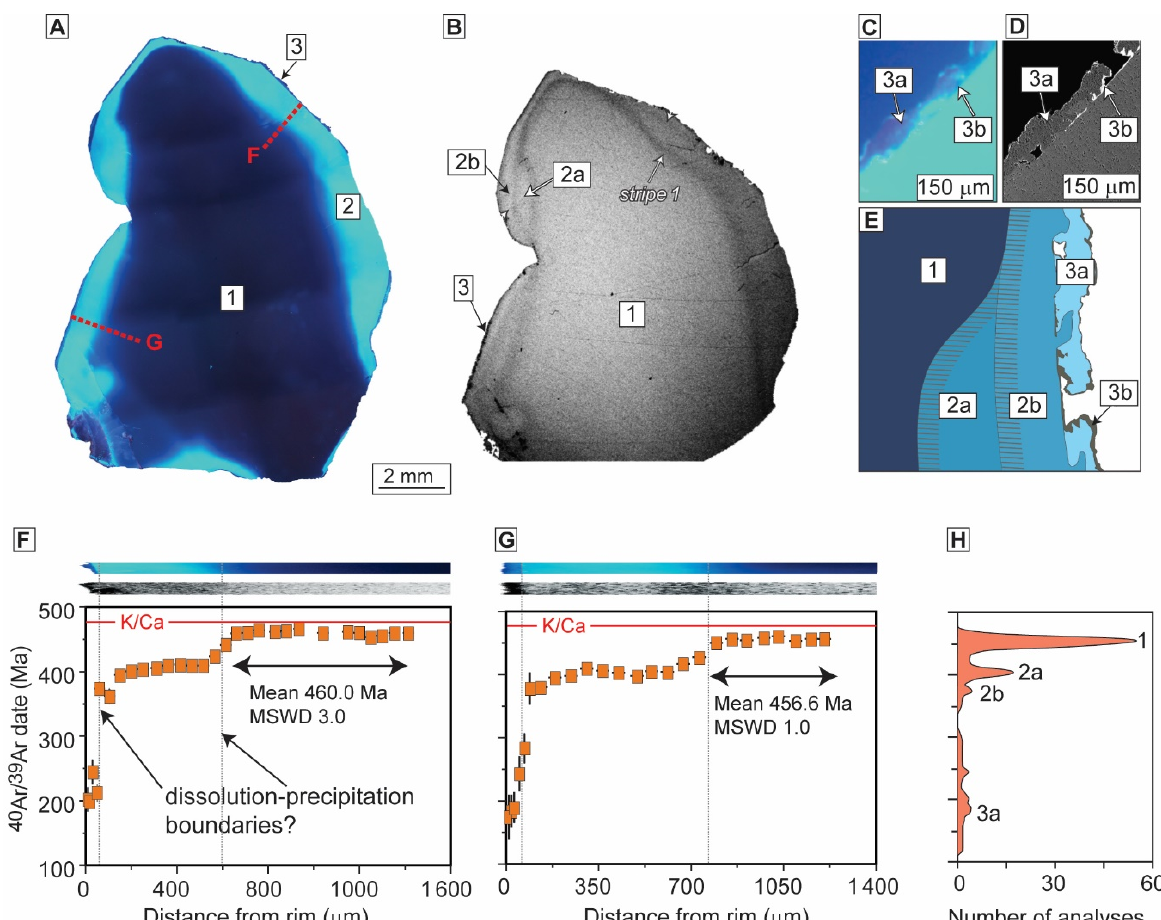
Figure 4. Gem quality orthoclase extracted from pegmatites at the site “Itrongay”, southern Madagascar, collected by the authors during field work in 2016. ( A ) Composite optical cathodoluminescence image showing three distinct zones (labeled 1, 2 and 3). ( B ) Back-scatter electron image which shows that zone 2 can be divided into two sub-zones (2a and 2b), which are separated by a dark stripe. ( C,D ) cathodoluminescence and back-scatter electron images of the outer ~300 μ m of the crystal, which show that zone 3 can be divided into 2 sub-zones (3a, 3b). ( E ) schematic sketch (not to scale) showing the relationships between all zones and their sub-zones. ( F,G ) In situ core-rim 40 Ar/ 39 Ar dates from our own in situ study [16], showing strip maps of back-scatter electron and cathodoluminescence images. Distinguishable variations in 40 Ar/ 39 Ar dates correspond with crystallographic zones, revealing periods of dissolution and diachroneity in crystallisation (~477–176 Ma). ( H ) Probability density function of all in situ 40 Ar/ 39 Ar dates collected from 8 traverses into the same crystal shown in ( A ). Detailed petrographic analyses of single crystals question previous interpretations that variations in in situ 40 Ar/ 39 Ar dates are dominated by volume diffusion. Data and images are from